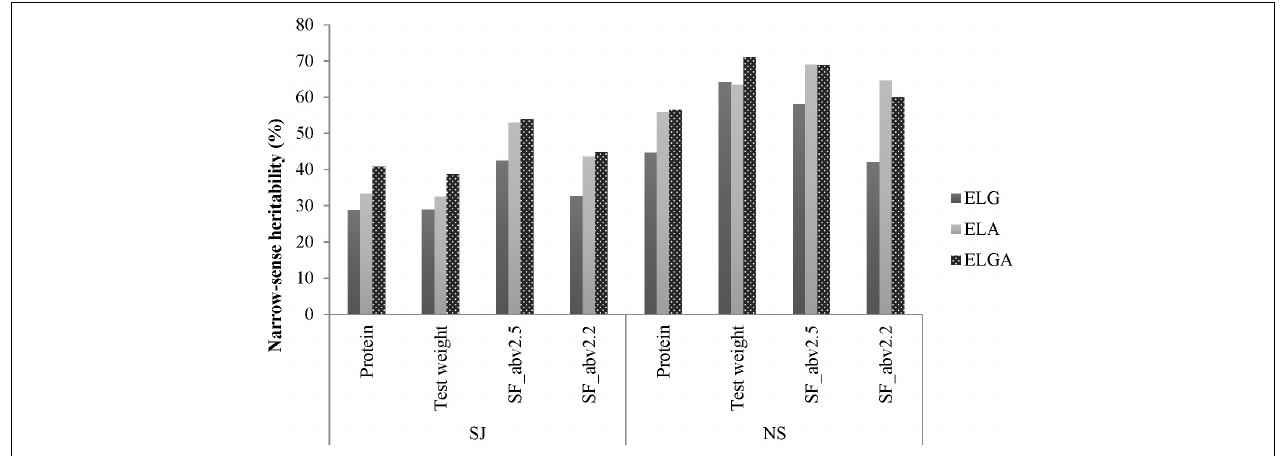
FIGURE 3 | Narrow-sense heritability estimates for all traits estimated with SJ and NS.